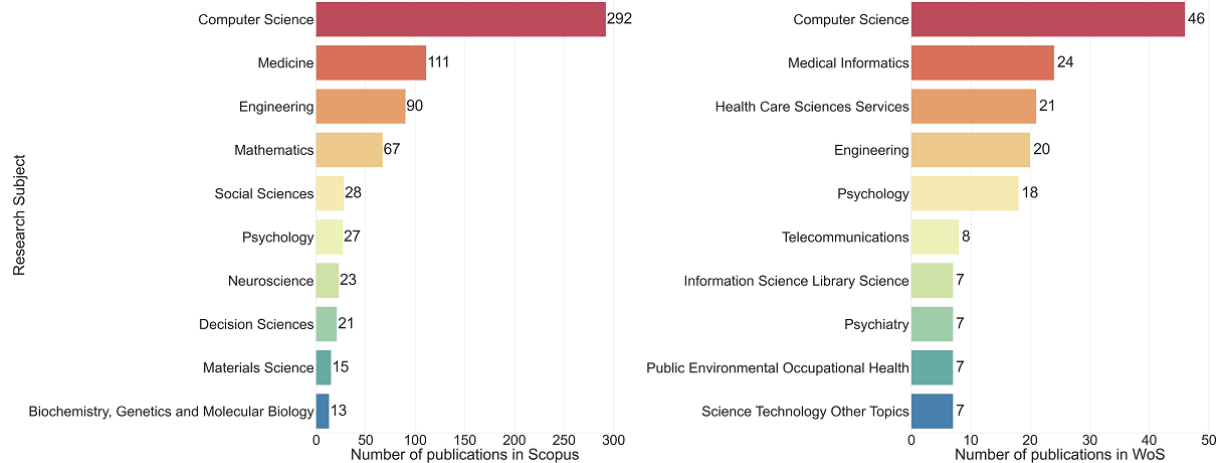
Figure 2. Publication count of top 10 research